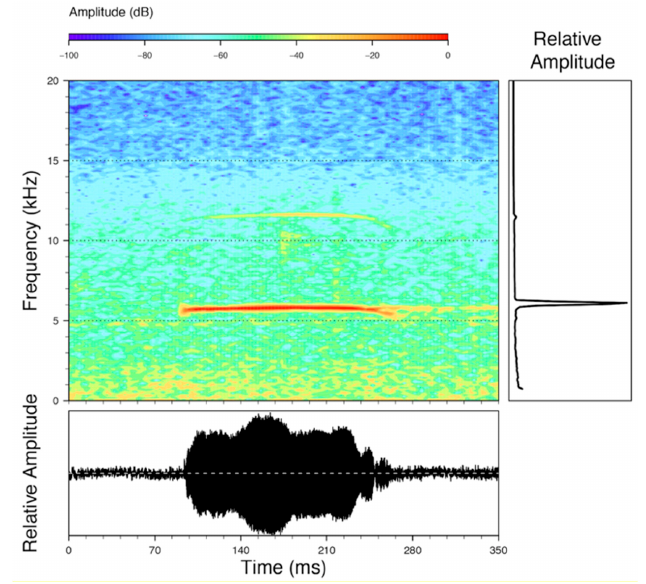
Figure 115. Vocalization of Hyalinobatrachium munozorum recorded at Río Bigal, 930 m, Orellana province, Ecuador, by Morley Read (LBE-C-020). Tadpole: Not described. Distribution (Figure 116): Hyalinobatrachium munozorum is known from localities in the Amazonian lowlands and Andean foothills of Colombia, Ecuador, Peru, and Bolivia at elevations below 980 m ([17,22,27,134,232], this work). In Ecuador, this species has been recorded from localities below 300 m; although, there is one juvenile (identification unconfirmed), found at 920 m (Specimens examined). In Ecuador, the potential distribution of the species is 101,986 km 2 .